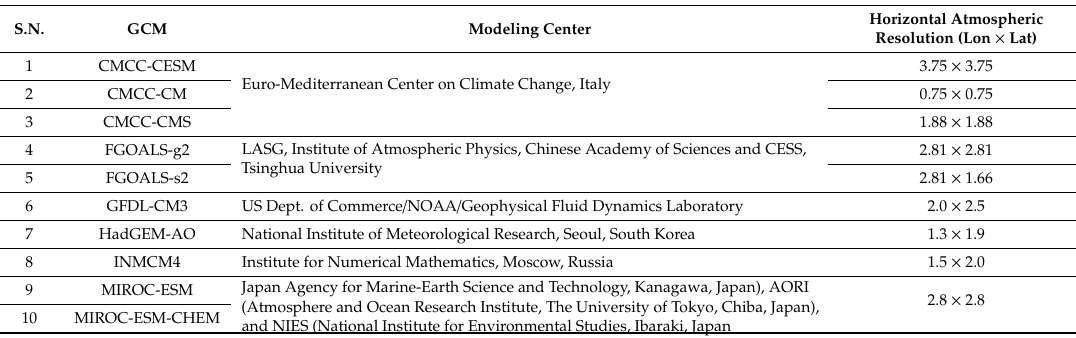
Table 5. GCMs used in this study and